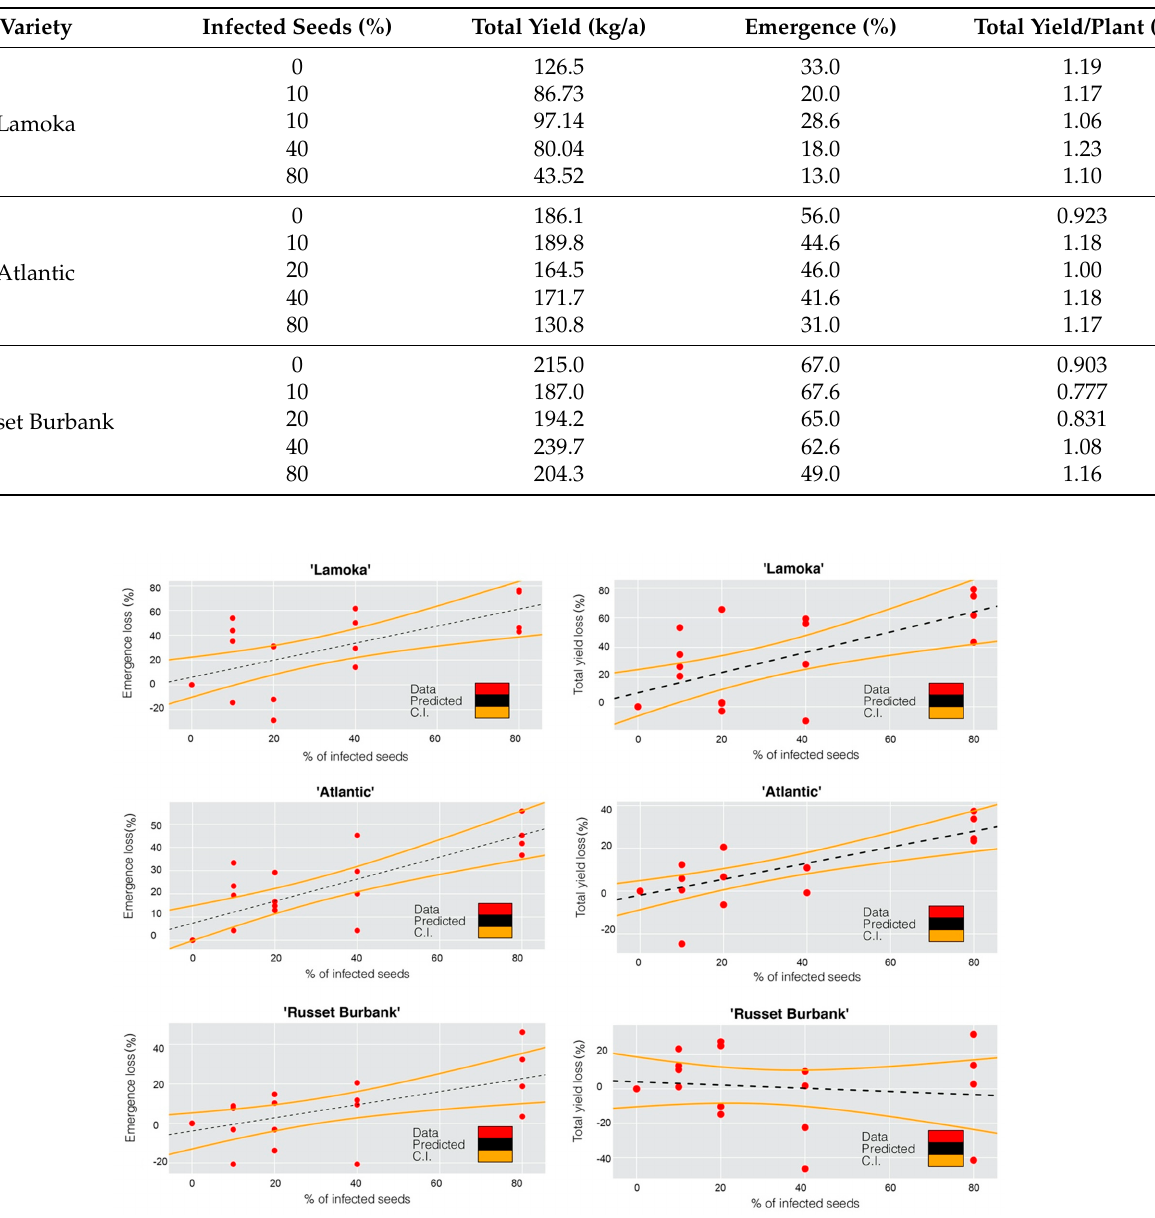
Figure 1. Correlation between (1) ( left panels ) emergence loss and infection percent of potato “Lamoka” ( r = 0.66, p = 0.0017), “Atlantic” ( r = 0.79, p < 0.0001), “Russet Burbank” ( r = 0.60, p = 0.0056) seed pieces inoculated with Dickeya dianthicola ; (2) ( right panels ) yield loss and infection percent of potato “Lamoka” ( r = 0.66, p = 0.0014), “Atlantic” ( r = 0.74, p = 0.0002), “Russet Burbank” ( r = 0.13, p = 0.5850) seed pieces inoculated with Dickeya dianthicola . Predicted data and confident intervals (CI) were shown as the dash lines and orange curves, respectively, 2020.